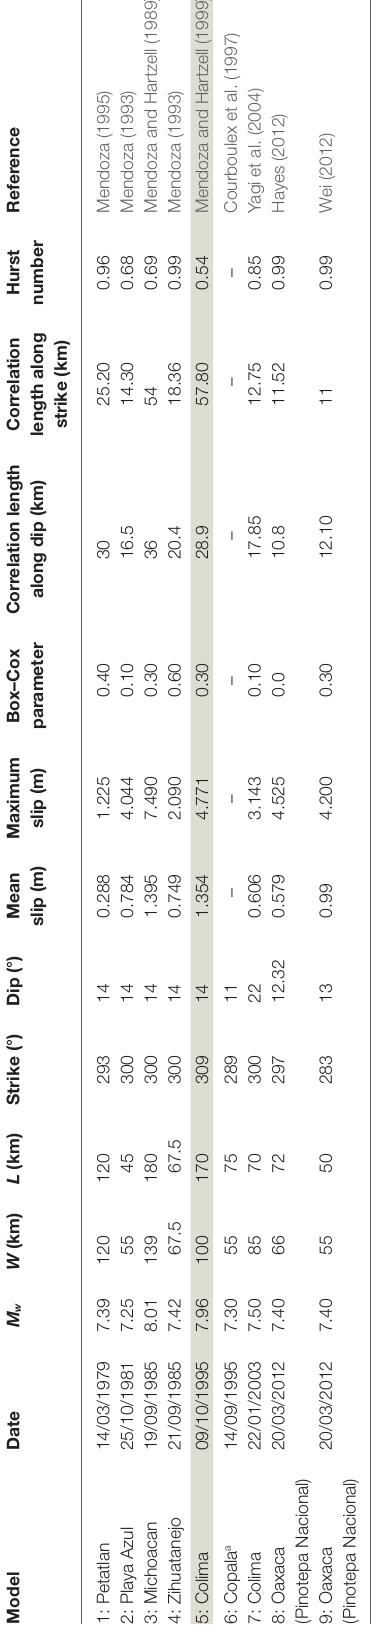
( Table 1 ) with the prediction models of the source parameters mentioned above is examined, and the results are shown in Figure 3 . In Figure 3 , the results for the 1995 Colima Earthquake by Mendoza and Hartzell (1999) are represented by a different symbol. The stochastic tsunami simulation of the 1995 Colima Earthquake is carried out, in comparison with the field obser- vations, in the latter part of this study. The results shown in Figure 3 indicate that the estimated source parameters agree with the scaling relationships; for most cases, the estimated parameters fall within the 16th–84th percentile confidence interval of the prediction equations, Eqs 1–6. Therefore, the use of the developed scaling relationships by Goda et al. (2016) for Mexican subduction events in the Guerrero region can be justified by the historical slip models along the Pacific Mexican subduction